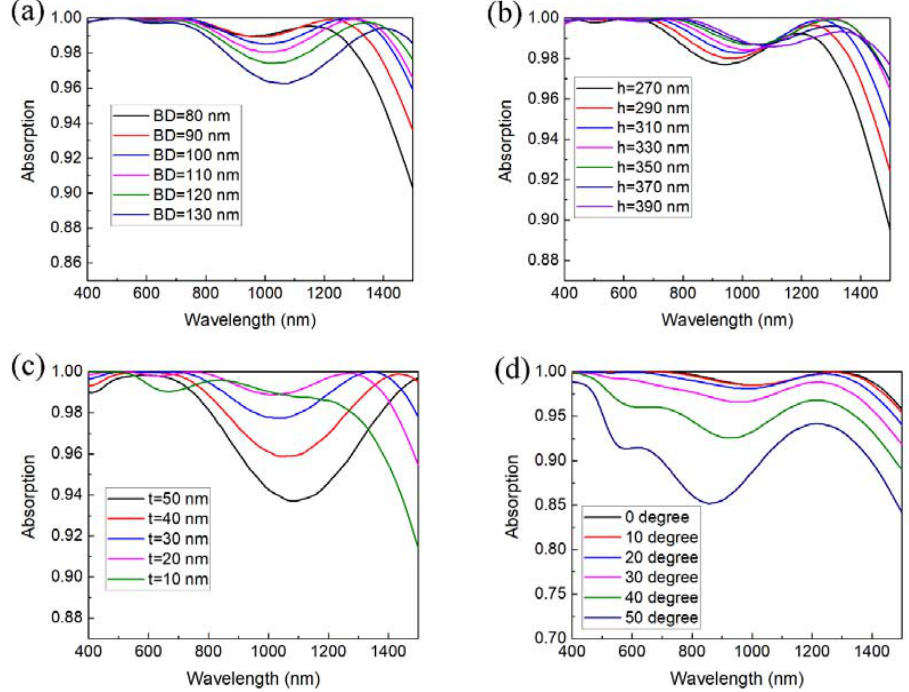
Figure 4. ( a ) Absorption spectra versus base diameter of the top TiN nanocone with the parameters fixed at h = 330 nm, and t = 25 nm; ( b ) absorption spectra versus height of the top TiN nanocones with BD = 100 nm, t = 25 nm; ( c ) absorption spectra versus thickness of the Al 2 O 3 spacer layer with BD = 100 nm, h = 330 nm; ( d ) absorption spectra versus incident angles.